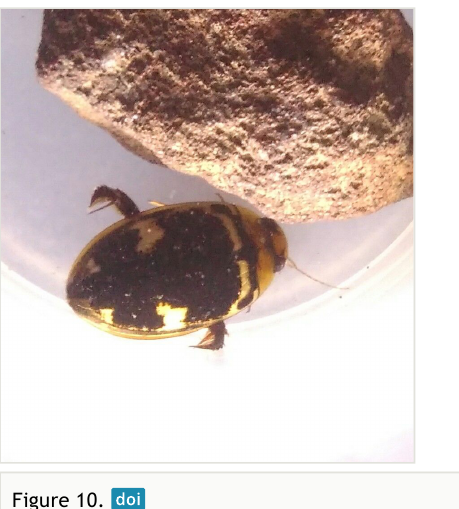
Figure 10. Hydaticus paci fi cus , HP image from